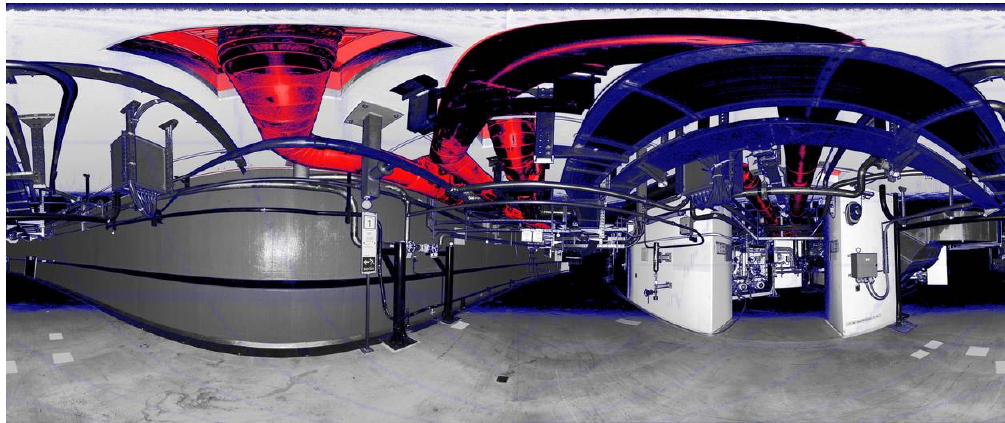
Figure 7. An example of blunder removal in a 3D scan. Blue: 3D points filtered automatically. Red: 3D points manually segmented (the average segmentation time is 6.5 minutes per station).